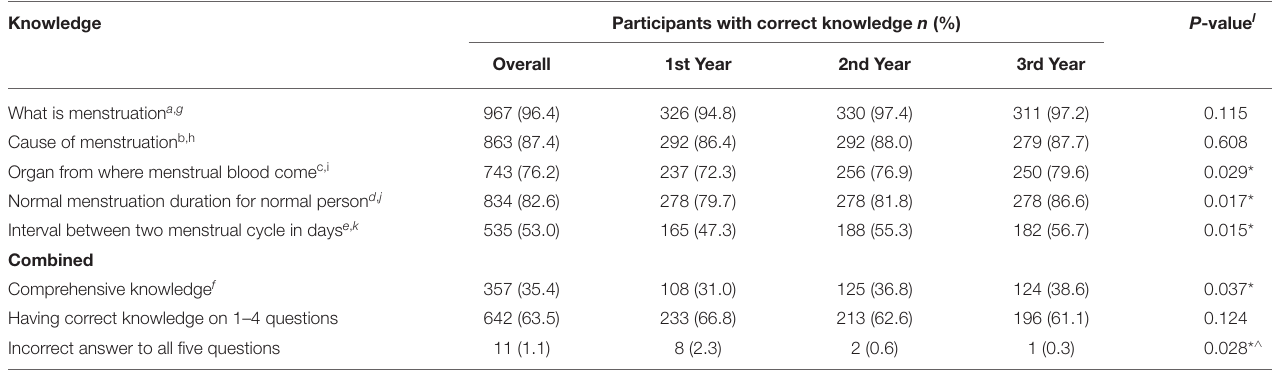
TABLE 2 | Number and percentage of female college students with appropriate knowledge about MHM ( n = 1,010). Knowledge